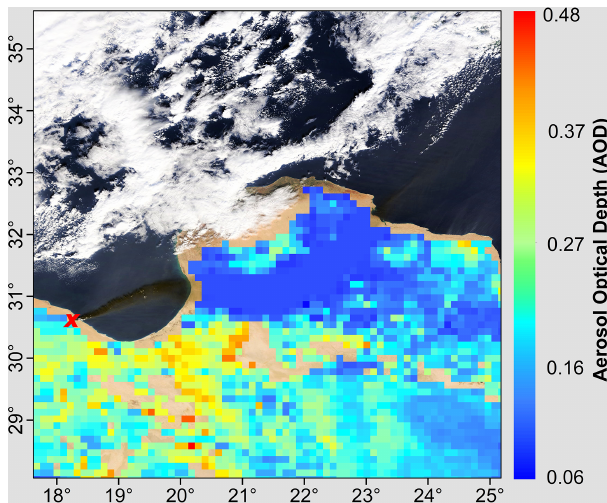
Figure 3. Retrieval of plume (unsuccessful) and background AOD values: event 13, 30 December 2014. The red coloured “x” indicates the event origin (satellite imagery from the NASA Worldview appli- cation, https://worldview.earthdata.nasa.gov, last access: 5 January